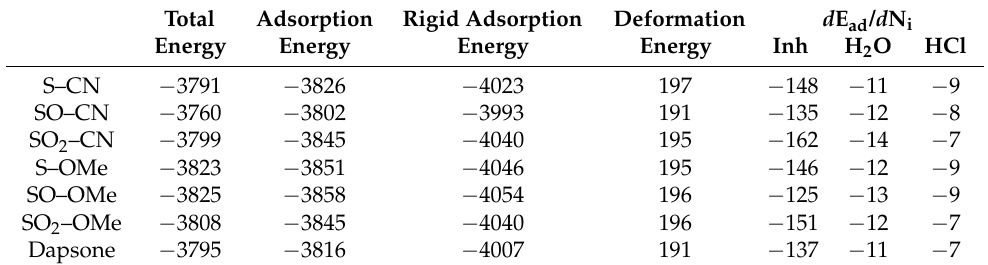
Table 4. The output adsorption descriptors (kcal/mol) for inhibitor/Fe(110) systems in acidic